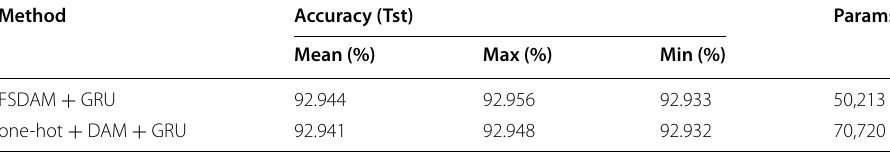
Table 9 Accuracy and parameters of different methods on UNSW-NB15 Method